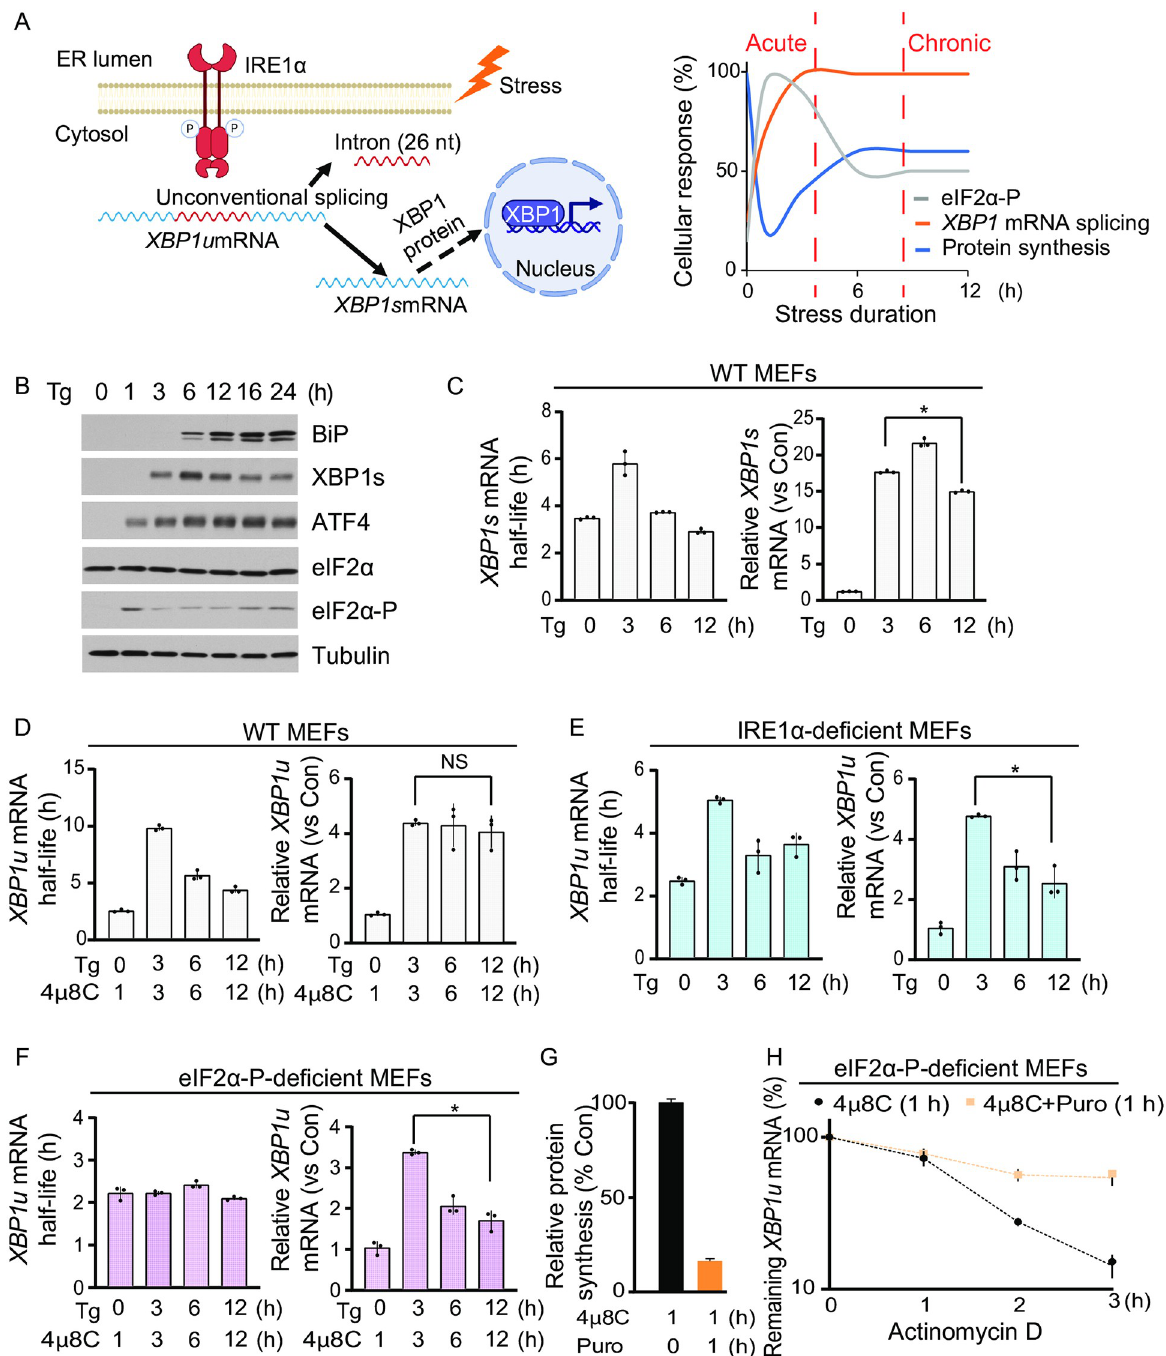
Fig 1. ER stress-induced translation inhibition stabilizes XBP1u mRNA during the acute UPR. (A) (Left) Unconventional splicing of XBP1 mRNA in the cytoplasm. Upon accumulation of misfolded proteins, the cytoplasmic endoribonuclease IRE1 α is activated and cleaves a 26-nucleotide (nt) intron from the coding region of the XBP1u mRNA. This process occurs in close proximity to the ER membrane. The resulting XBP1s mRNA is translated in the cytoplasm, and the XBP1s protein migrates to the nucleus to induce transcription of genes that protect cells from ER stress. The figure was created by Biorender.com (Right) Schematic of temporal responses to ER stress. This response includes an acute phase up to 3 h, and a chronic phase, beyond 6 h of treatment with stressors. (B) Western blot analysis of the indicated proteins in MEFs treated with Tg (400 nM) for the indicated durations. (C) (Left) The half-life of the spliced XBP1 mRNA ( XBP1s ) was determined by treating MEFs with Tg for the indicated durations. Actinomycin D (10 μ g/ml) was added for 0, 0.5, 1, 2, 3, and 4 h at each indicated time of Tg-treatment to inhibit transcription and measure the mRNA decay rate at different time points of ER stress. (Right) The XBP1s mRNA levels were quantified by RT-qPCR. (D) The